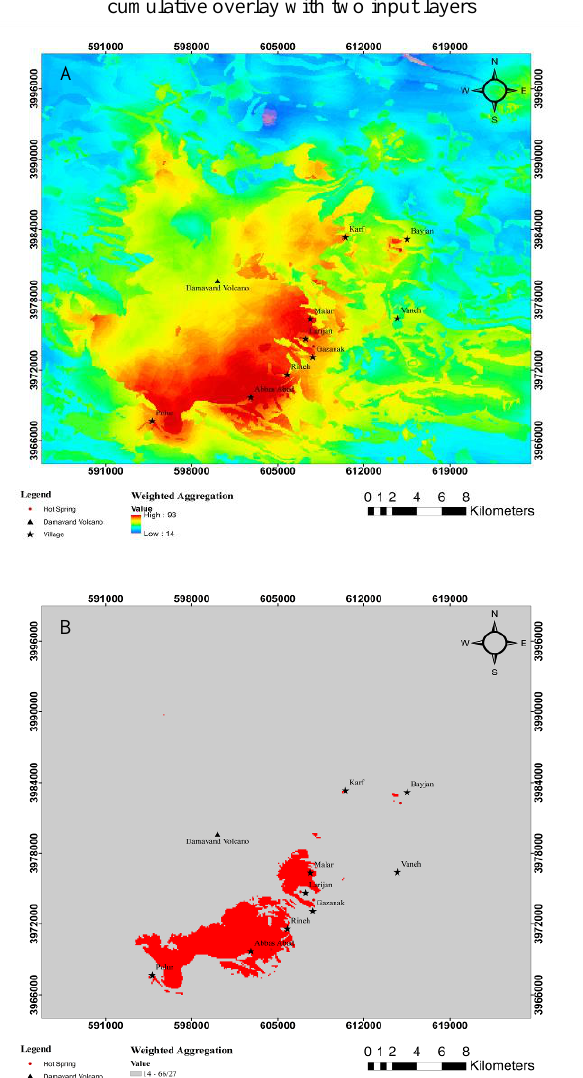
Figure 8. A) The result of cumulative overlay. B) The result of